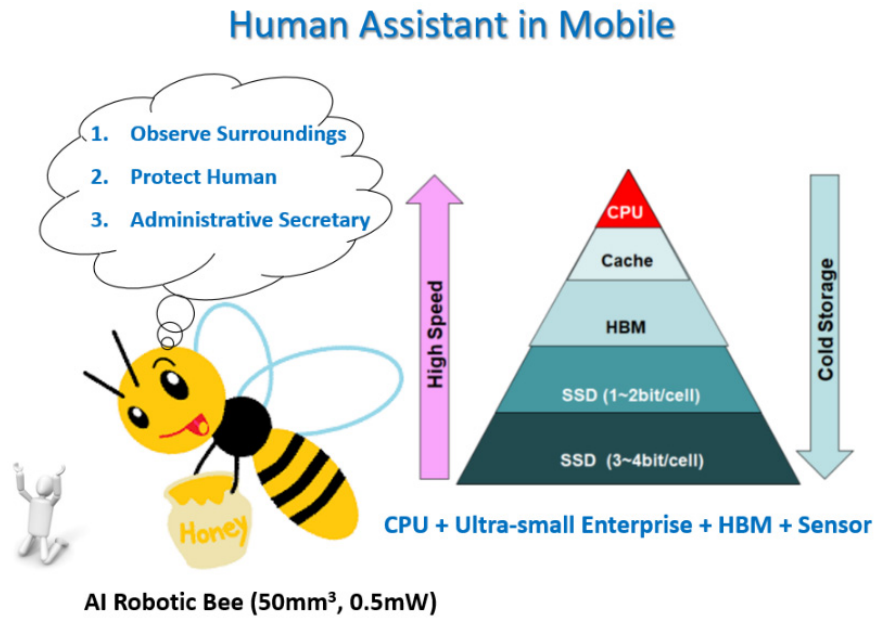
Figure 45. AI Robotic Bee (50 mm 3 , 0.5 mW) as a human